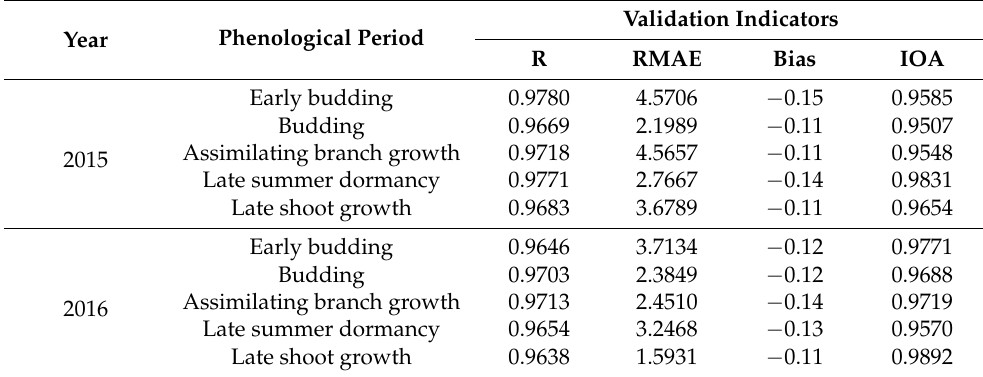
Figure 7. Reference evapotranspiration ET 0 and actual evapotranspiration ET a for H. ammodendron vegetation. Table 6. Verification of ET g using water balance method and groundwater level fluctuation method ( WTF ).